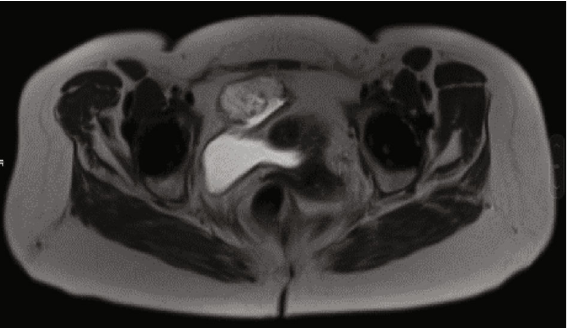
Figure 2: Magnetic resonance imaging showing a lesion at the expense of the bladder wall.